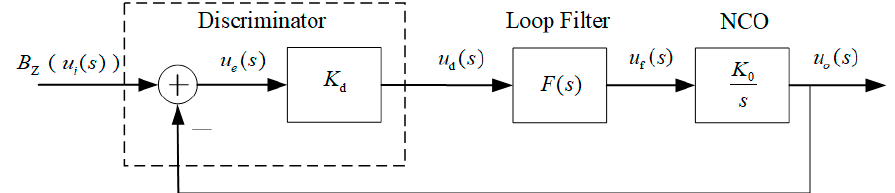
Figure 5. Block diagram of phase-locked loop in frequency domain (Laplace transform) .